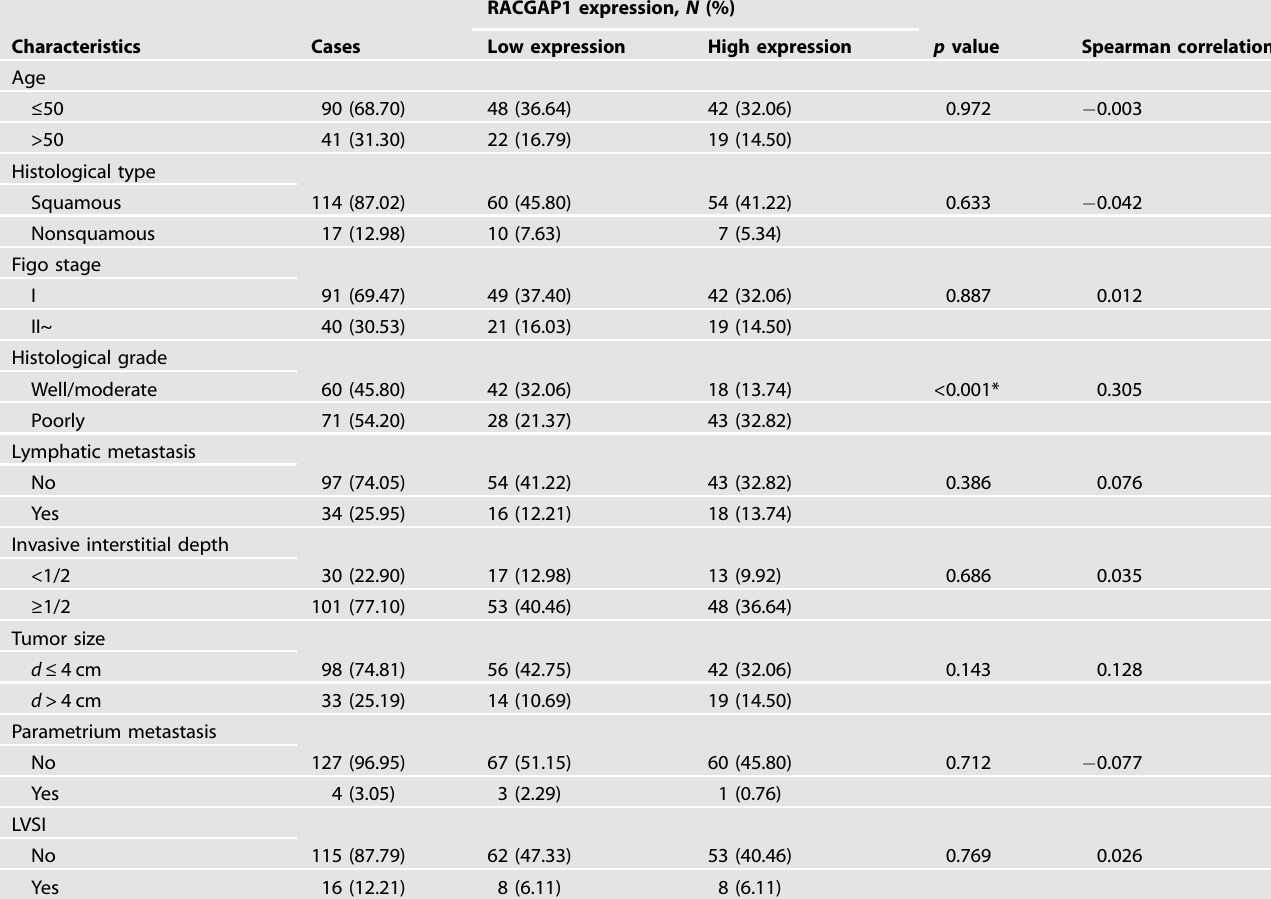
FIGO International Federation of Gynecology and Obstetrics, LVSI lymph-vascular space invasion, RacGAP1 Rac GTPase-activating Protein 1.